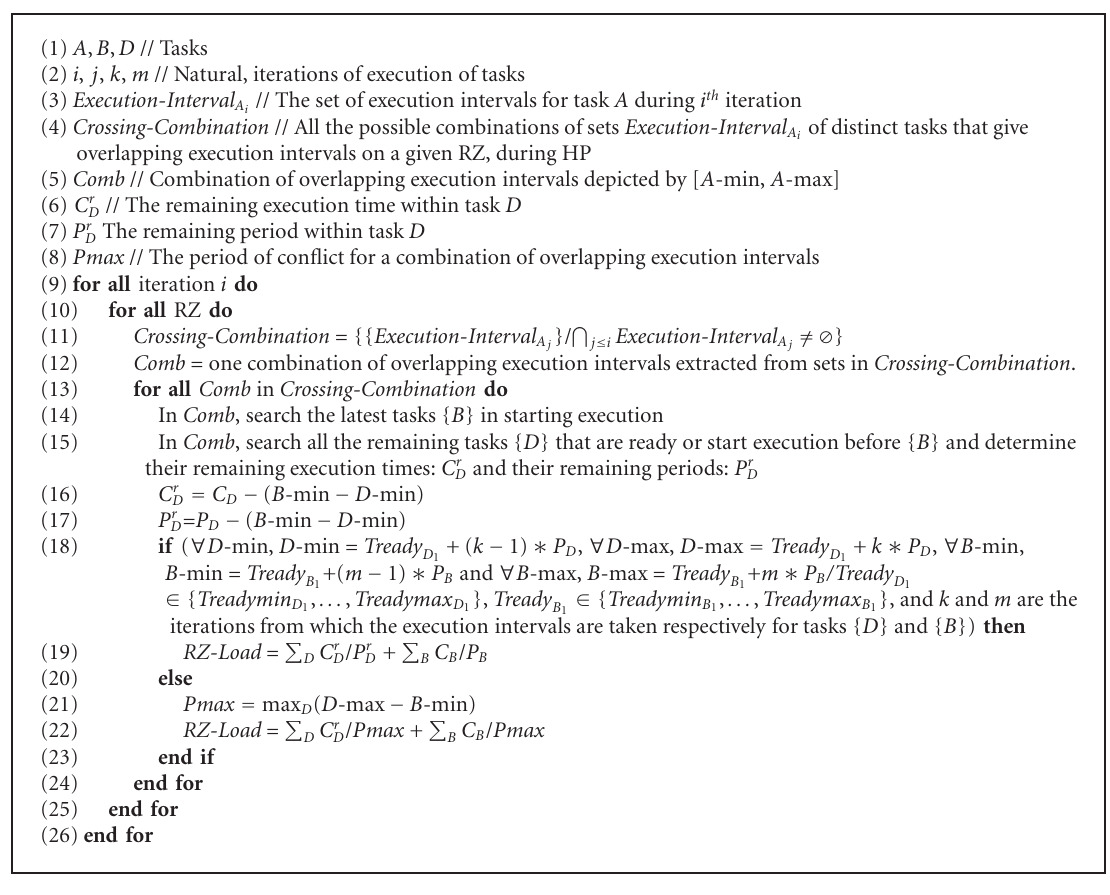
Algorithm 4 is O (2 NT ∗ HP ∗ NT ∗ NZ). Algorithm 4